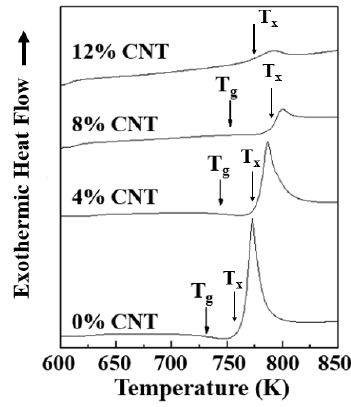
Figure 2. Differential scanning calorimeter (DSC) scans of mechanically alloyed Ti 50 Cu 28 Ni 15 Sn 7 and composite powders after 8 h milling. T g : Glass transition temperature; T x : Crystallization temperature.